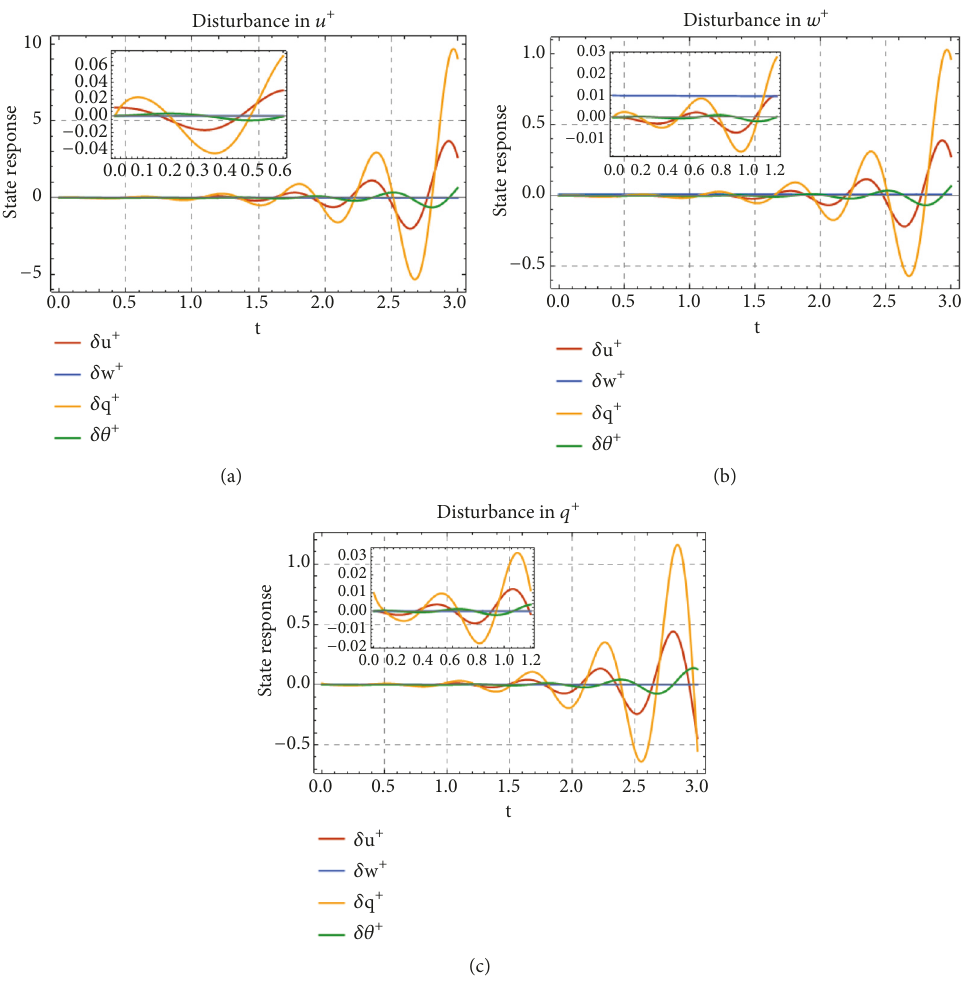
Figure 2: State response for disturbance of the open-loop system.